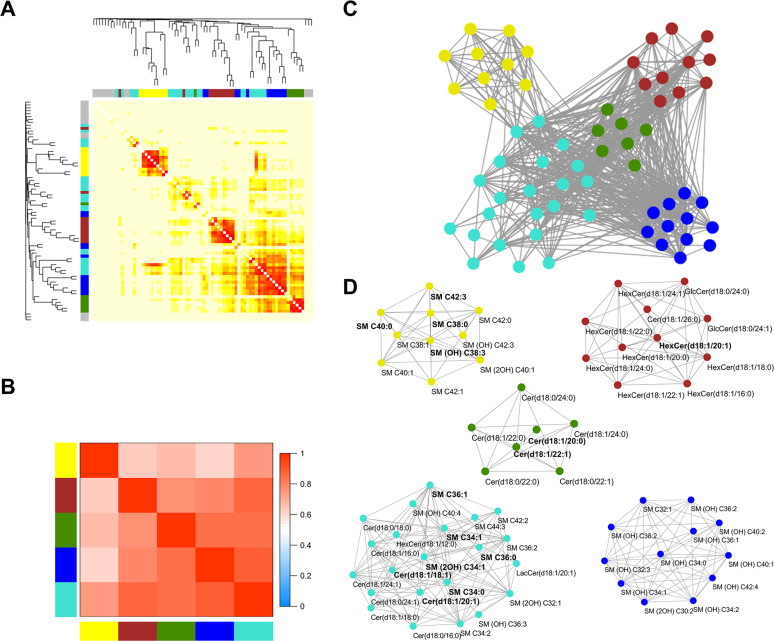
Weighted gene co-expression network analysis (WGCNA) of sphingolipid profile.(A) Cluster dendrogram and heatmap correlation of 76 sphingolipids. Color bars on the left and at the top represent 5 identified modules. Sphingolipids that could not be clustered to any 1 module are labeled gray. (B) Correlation heatmap among the 5 modules. Color bars on the left and at the bottom represent modules, and grid squares indicate Pearson correlation coefficients among module eigengenes. (C) Colors indicate the modules detected by topological overlap measure (yellow: very long-chain SMs, including saturated SMs; turquoise: long-chain Cers and SMs, including saturated SMs; green: very-long-chain Cers and dhCers; brown: GSLs; blue: hydroxyl-SMs). (D) Five sub-networks are shown as node and edge graphs. Sphingolipids are presented as nodes. Within each module, those nodes significantly associated with incident type 2 diabetes are labeled bold. Cer, ceramide; dhCer, dihydroceramide; GlcCer, glucosylceramide; GSL, glycosphingolipid; HexCer, hexosylceramide; LacCer, lactosylceramide; SM, sphingomyelin; SM (OH), hydroxyl-sphingomyelin with 1 additional hydroxyl; SM (2OH), hydroxyl-sphingomyelin with 2 additional hydroxyls.